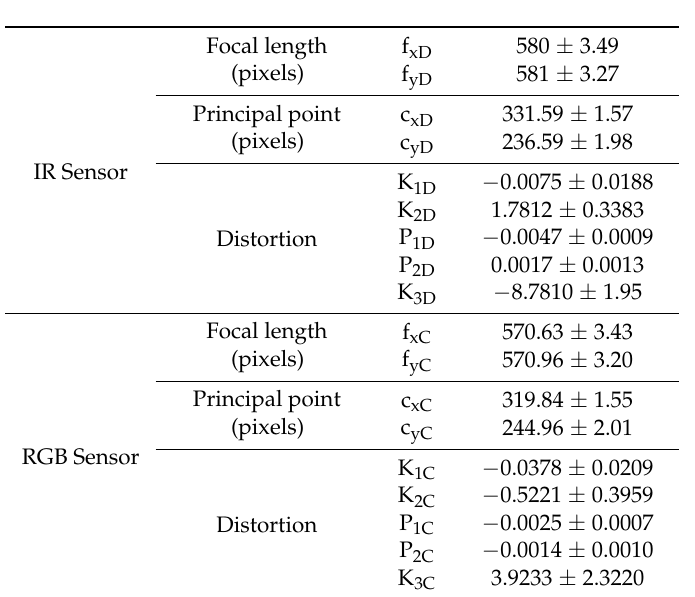
Table 2. Calibration results of the IR camera and RGB